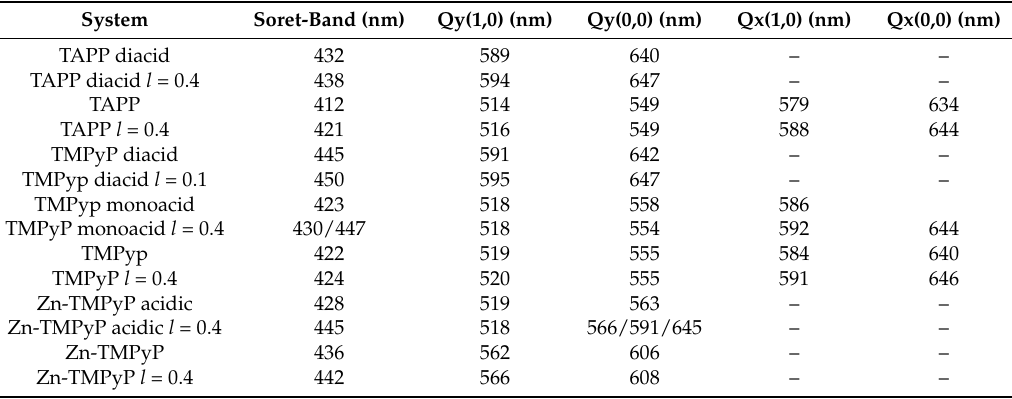
Figure 3. Spectral changes of porphyrin-PSS brush aggregates upon changing the pH from neutral to highly acidic: ( a ) TAPP-sample with PSS brush l = 0.4; ( b ) Zoom of the Q bands of ( a ); ( c ) TMPyP-sample with PSS brush l = 0.1 for the diacid and monoacid, l = 0.4 under neutral conditions; ( d ) Zoom of the Q bands of ( c ); and ( e ) Zn-TMPyP-sample with PSS brush l = 0.4; ( f ) Zoom of the Q bands of ( e ). Table 2. Spectroscopic data for porphyrin-PSS brush assemblies in different